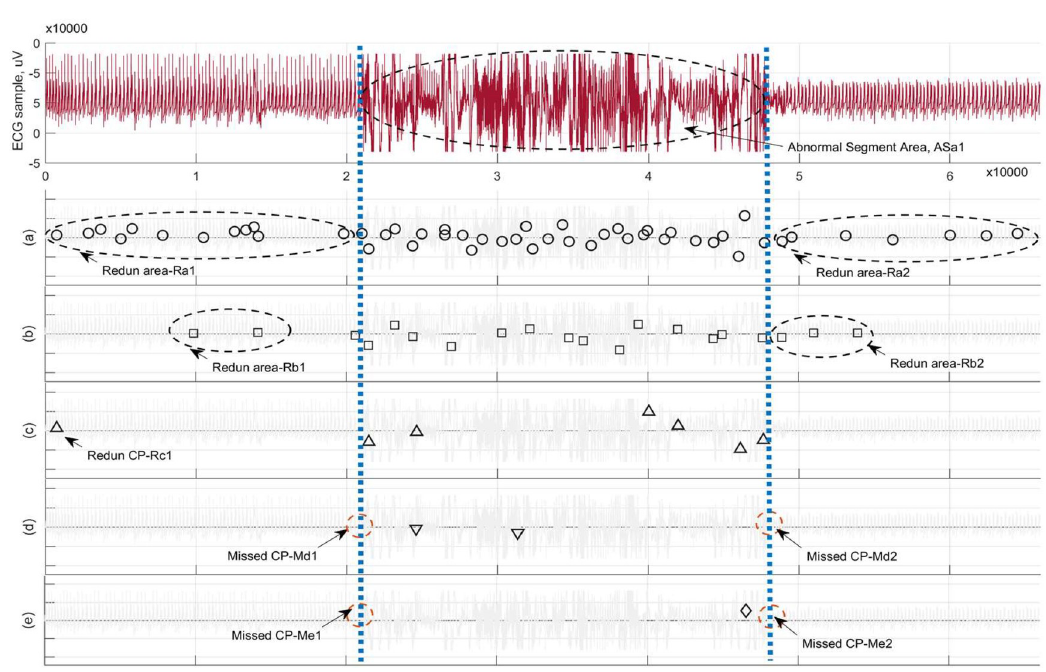
Fig 9. The results of MCPs detection on ECG sample from one of 22 pathological signals in the nfle10_edfm by using TST method in the FSW framework. In accordance with the partitions of ECG sample, the resultant MCPs are illustrated as the size of Nw is equal to (a) 2^10, (b) 2^11, (c) 2^12, (d) 2^13, and (e) 2^14, respectively.